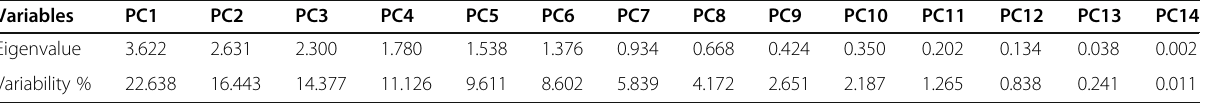
Table 8 Eigenvalues and principal components for yield and fiber attributes in cotton genotypes Variables Variability %